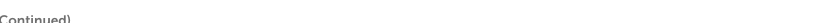
FIGURE5(Continued) output maps show the differences in activation between the Story and Math conditions. (E) QuNex also supports multi-variate and joint inference tests for testing hypotheses using data from multiple modalities, such as BOLD signal and dMRI. Example connectivity matrices are shown for